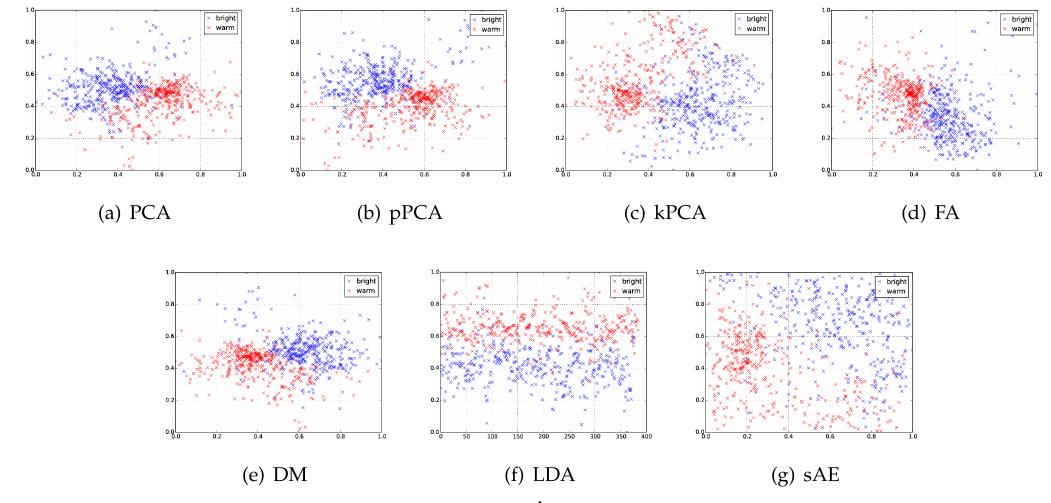
Figure 4. Two-dimensional parameter-space representations using seven data reduction techniques, where the red data points are taken from parameter spaces described as bright and the blue points are described as warm . ( a ), ( c ), ( f ), and ( g ). PCA: Principal Components Analysis; pPCA: Probabilistic